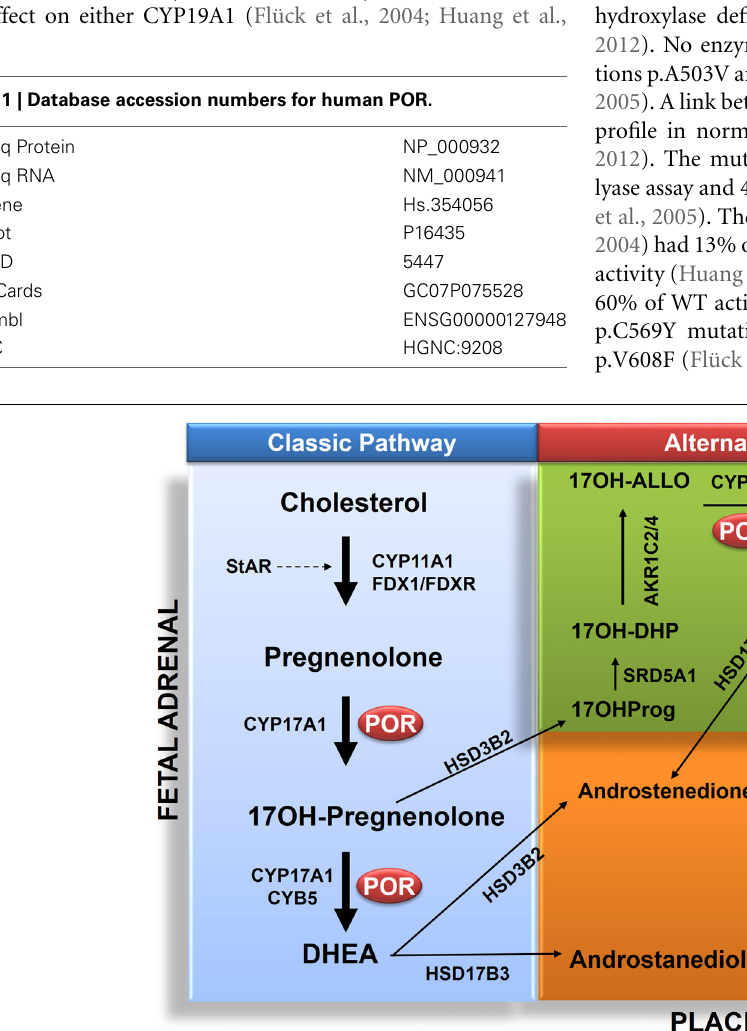
testis. Abbreviations: CYP11A1, P450scc, cholesterol side-chain cleavage enzyme; StAR, steroidogenic acute regulatory protein; FDX1, Adrenodoxin; FDXR, NADPH adrenodoxin oxidoreductase;